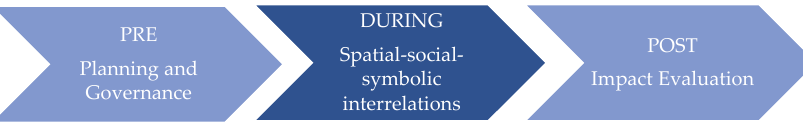
Figure 12. A tentative processual scheme addressing different research topics.